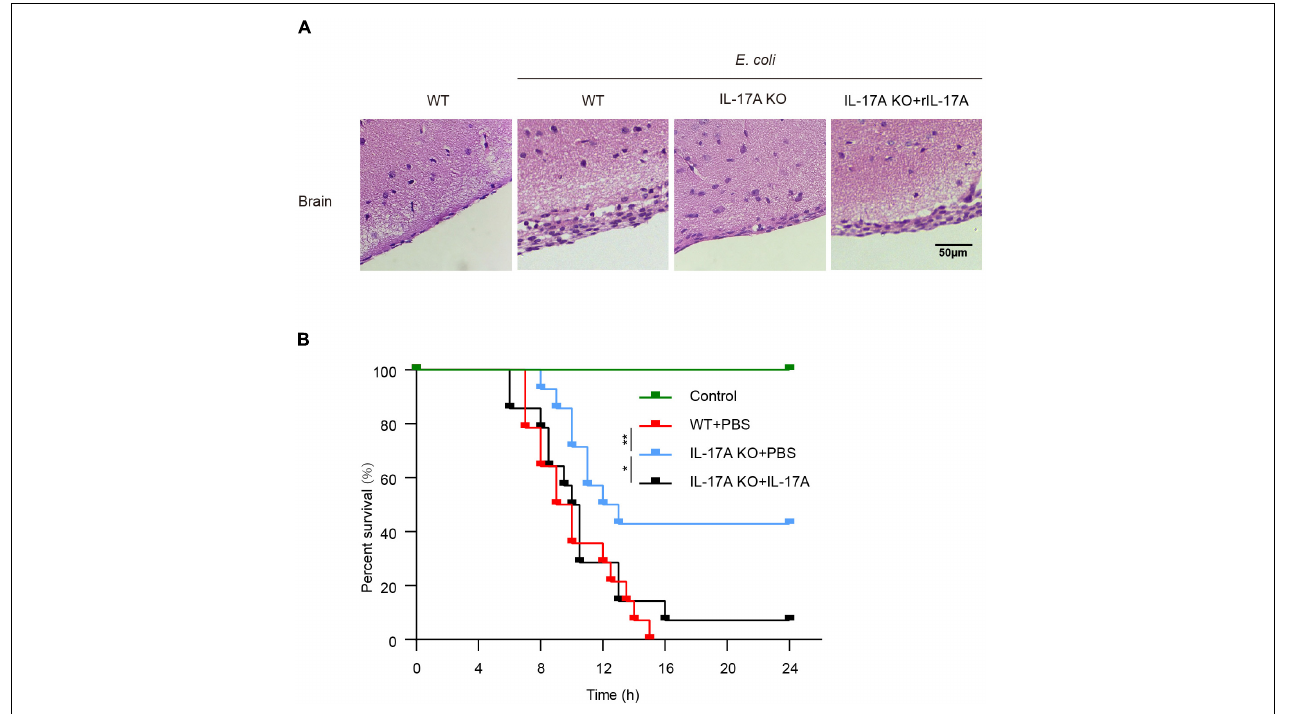
FIGURE 6 | Interleukin-17A aggravated brain tissue damage and reduced survival rate in E. coli -infected mice. (A) WT mice, IL-17A KO mice with or without adding recombinant IL-17A, were infected with E. coli , the histopathological changes in the brain were investigated by H&E staining. Scale bar indicates 50 µ m. (B) Survival analysis curves for WT mice, IL-17A KO mice with or without adding recombinant IL-17A infected with E. coli . Data were collected and shown as Kaplan–Meier survival curves from 14 individual mice. * p < 0.05 and ** p <